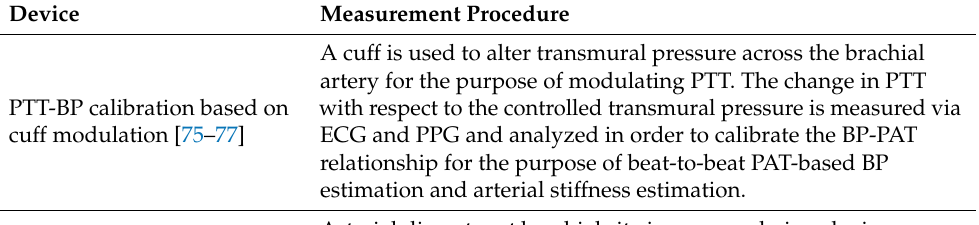
Table 1. Cont. Device Measurement